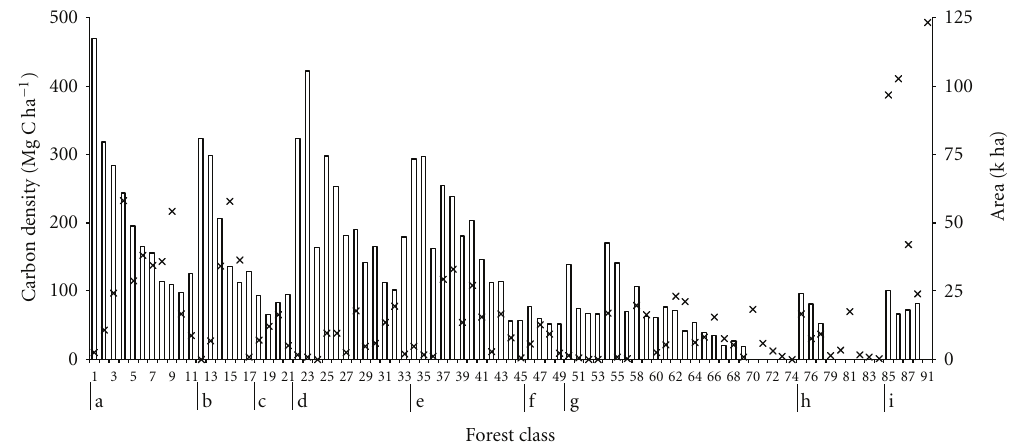
Figure 3: Areas and standing-tree carbon densities of Forest Classes in Tasmanian State forest. Forest Classes 57, 78, 89, and 90 are omitted. For a more complete description of Forest Classe, refer to Table 1. Bars denote carbon density, crosses denote area. a: mature eucalypt, b: mature eucalypt with unheighted regrowth, c: mature eucalypt with silvicultural regeneration, d: unaged eucalypt regrowth with mature eucalypt, e: pure unaged regrowth eucalypt, f: regrowth eucalypt with silvicultural regeneration, g: even aged eucalypt silvicultural regeneration, h: unstocked, and i: noneucalypt forest.